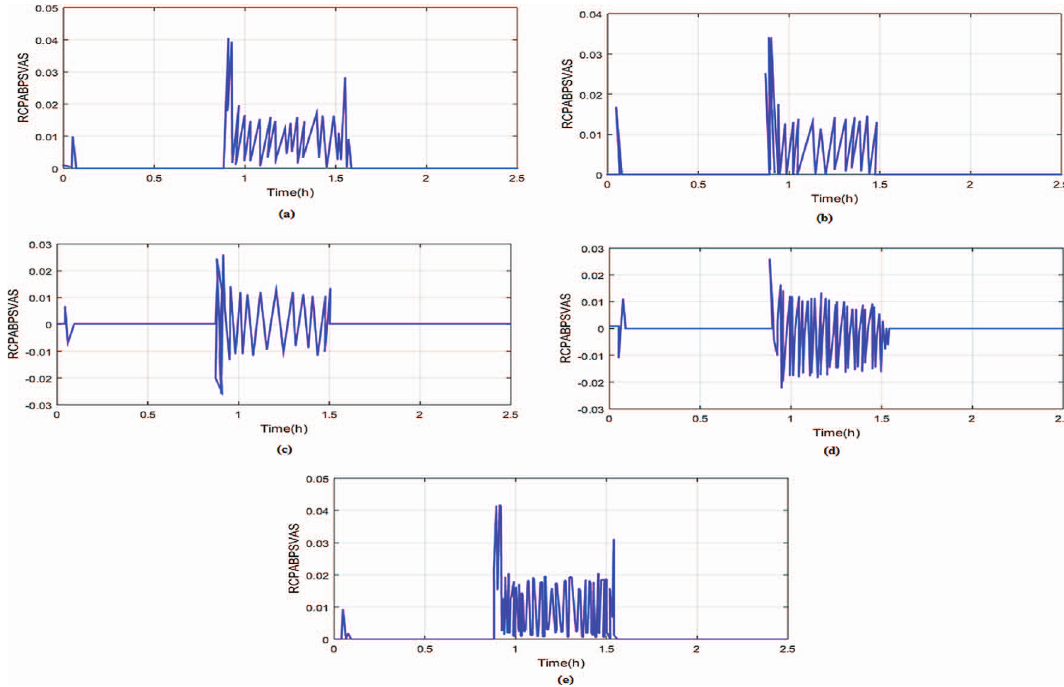
Fig. 8. System performance under normal loading